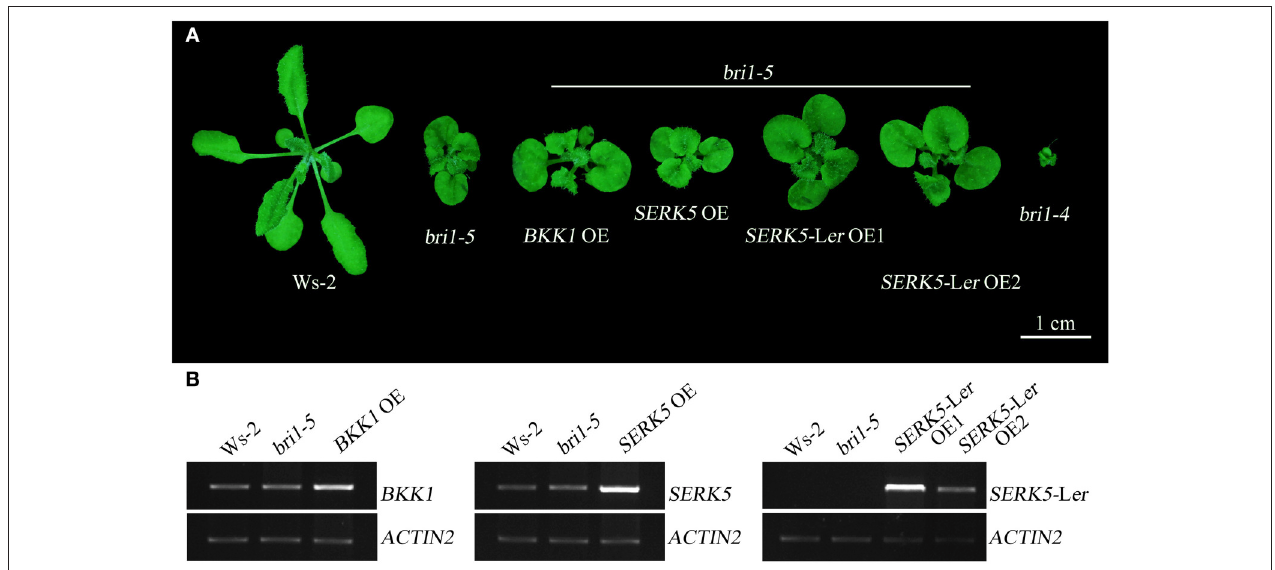
FIGURE 2 | Overexpressing SERK5 -L er can partially suppress bri1-5 phenotype. (A) Overexpression of SERK5- L er and BKK1 , but not SERK5 , can partially suppresses the phenotypes of bri1-5 , a weak BRI1 mutant. bri1-4 is a null BRI1 mutant allele. (B) RT-PCR analyses to confirm the elevated expression of the transgenes in bri1-5 . The PCR amplification cycles for BKK1 , SERK5, SERK5 -L er and quantitative control ACTIN2 , are 28, 28, 27, and 19, respectively.